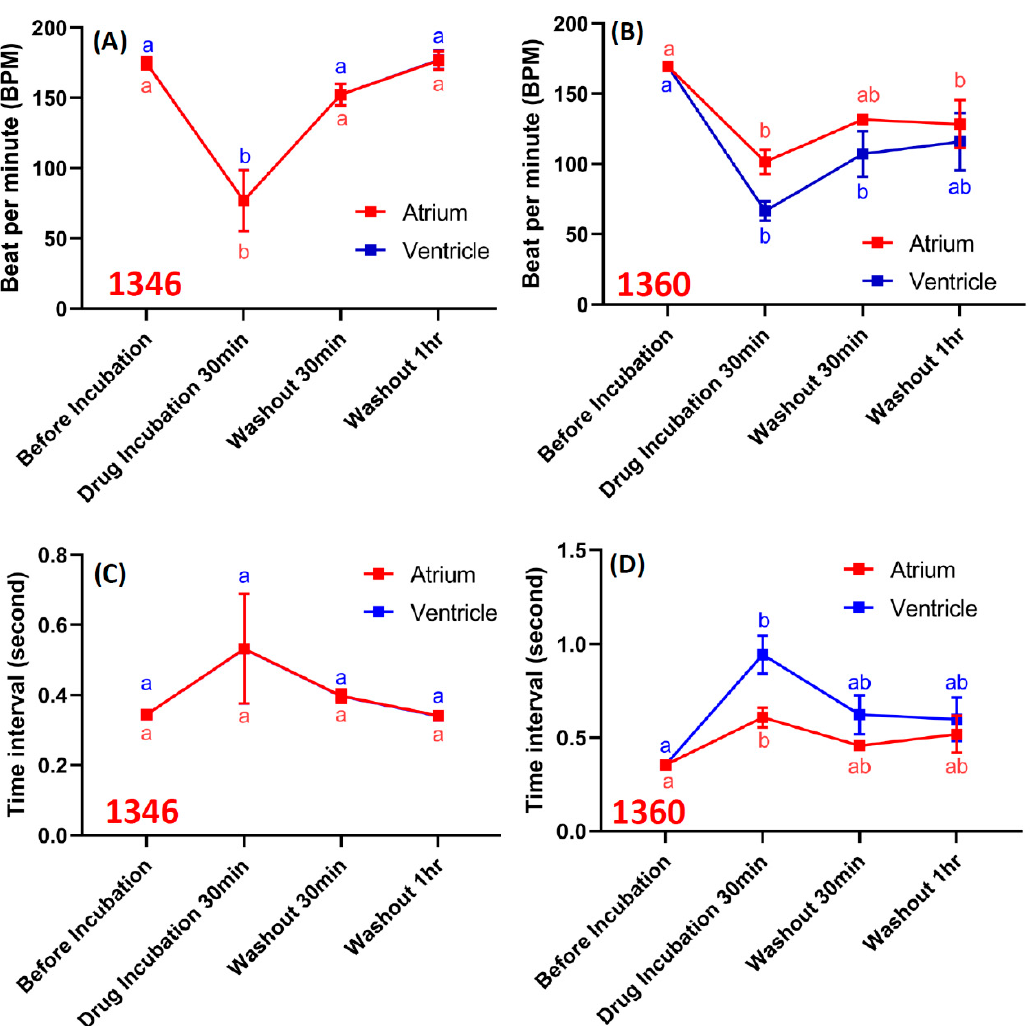
Figure A2. Washout experiment to show the heart rate and rhythmicity can be restored in the absence of the compound. The heart beat rate (red color for artrium and blue color for ventricle) before, during and after compound 1346 (FPL-64176) and 1360 (Pimozide) treatment was shown in A and B . The heart rhythmicity (red color for artrium and blue color for ventricle) before, during and after compound 1346 and 1360 treatment was shown in C and D . The data was expressed as mean ± S.E.M. and bars sharing a letter are not significantly different from one another as assessed by one-way ANOVA, followed by Fisher’s least significant difference test ( p < 0.05). Five zebrafish larvae aged at 72 h post-fertilization (hpf) were used in this assay.